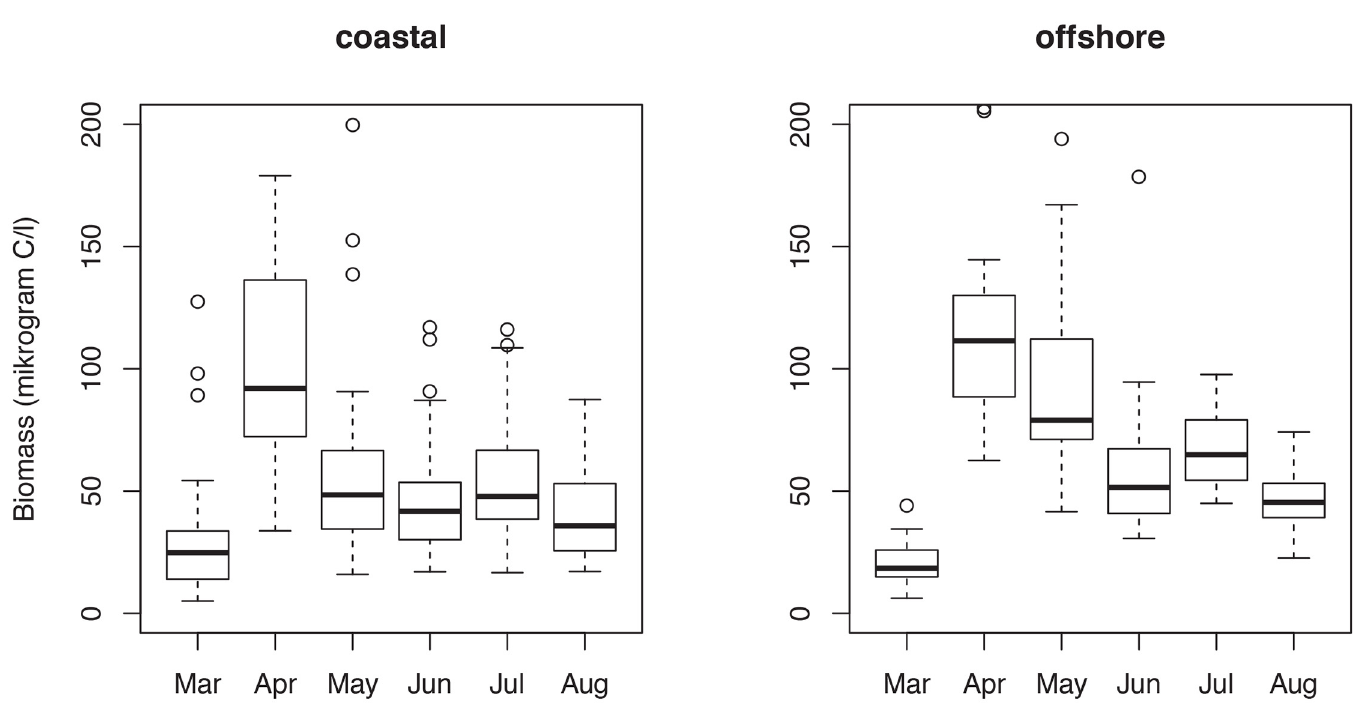
Fig 2. Phytoplankton biomass. Box plots showing phytoplankton biomass (microgram C L -1 ) between March and August for the period 1994 – 2011 at two sites (coastal, offshore) in the Baltic Sea. Two periods with peak biomass in April and July occur at both sites, and characterize distinct spring and summer phytoplankton blooms in the Baltic